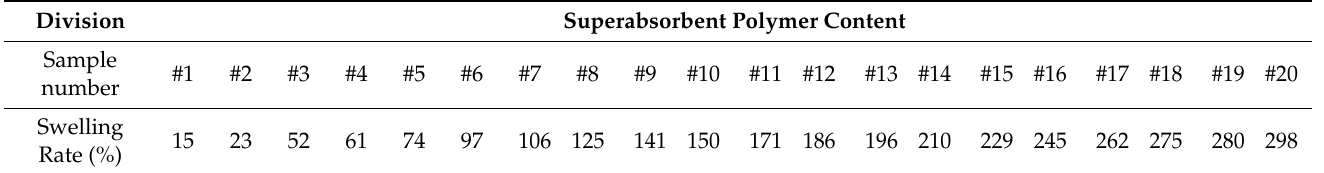
Table 5. The swelling rate evaluation results according to the superabsorbent polymer